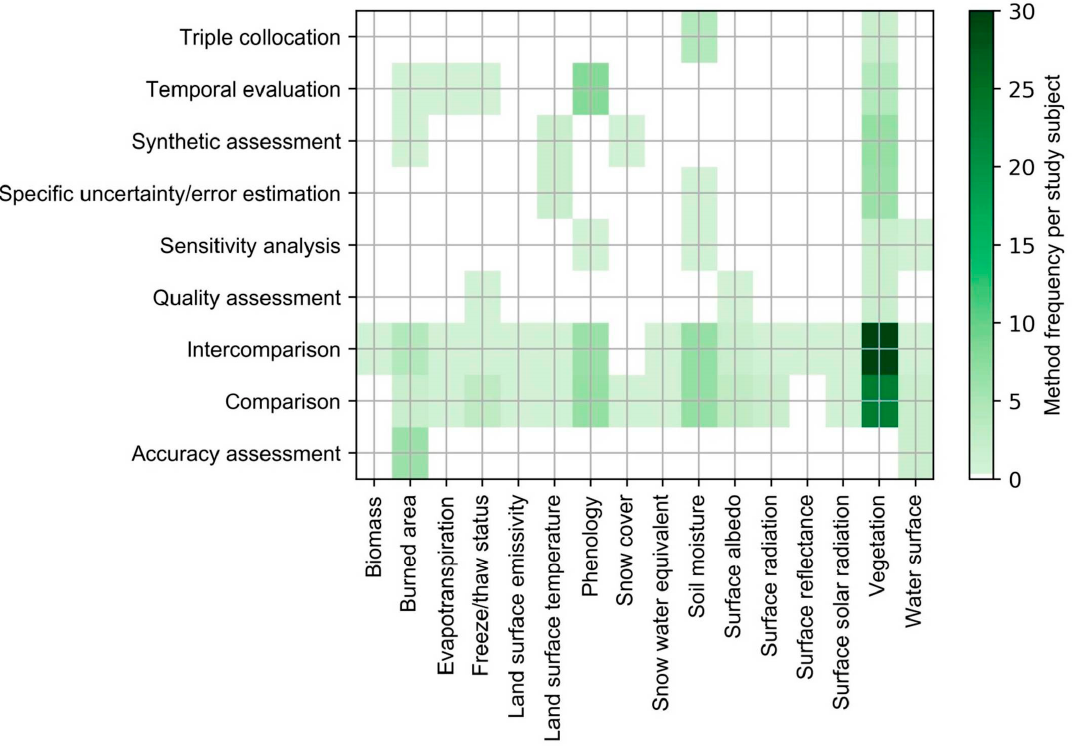
Figure 13. Frequency of the applied validation methods according to study subjects.